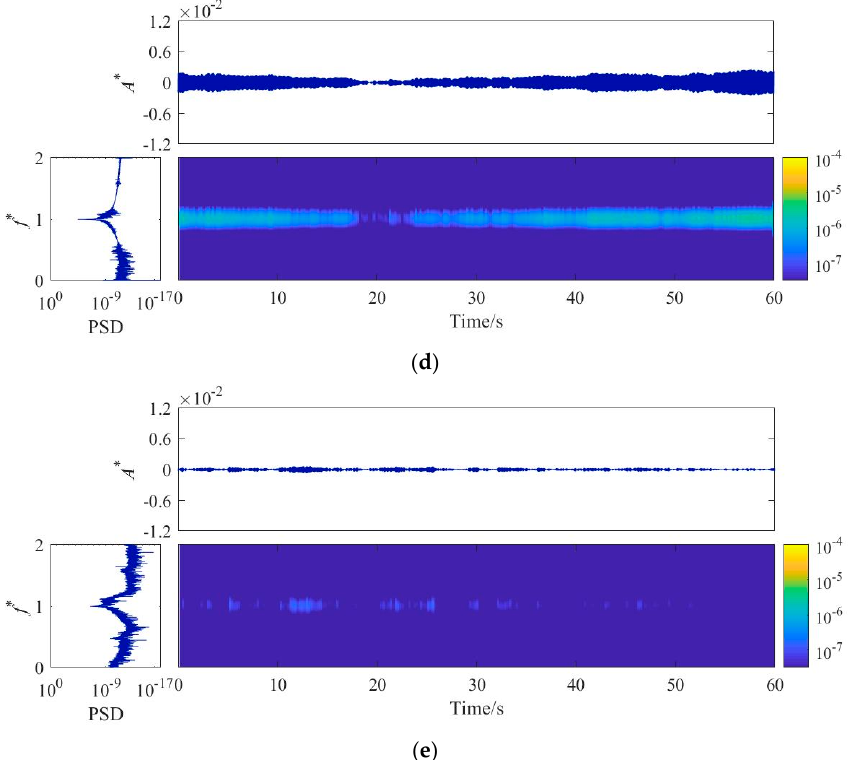
Figure 8. The time-frequency analysis of displacement of the steel tube at various U*. ( a ) Initial stage ( U* = 4.31); ( b ) Rising stage ( U* = 4.70); ( c ) Stable stage ( U* = 4.88); ( d ) Declining stage ( U* = 5.05); ( e ) End stage ( U* = 5.18).